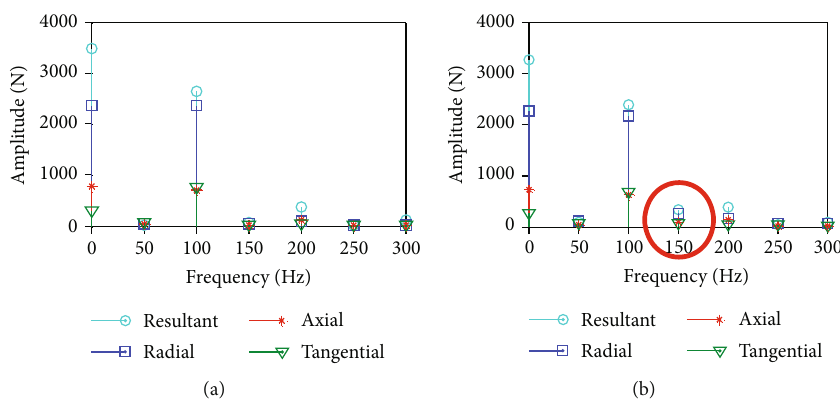
Figure 7: Electromagnetic force spectrum of the QFSN-600-2YHG generator: (a) in normal and (b) under RISC.